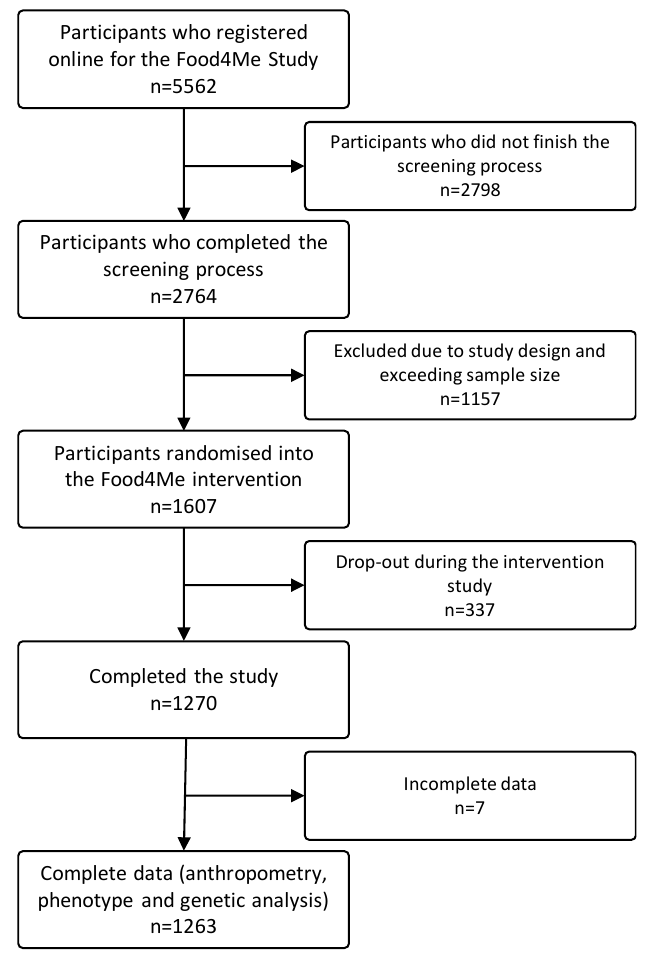
Figure 1. Flowchart of sample selection.